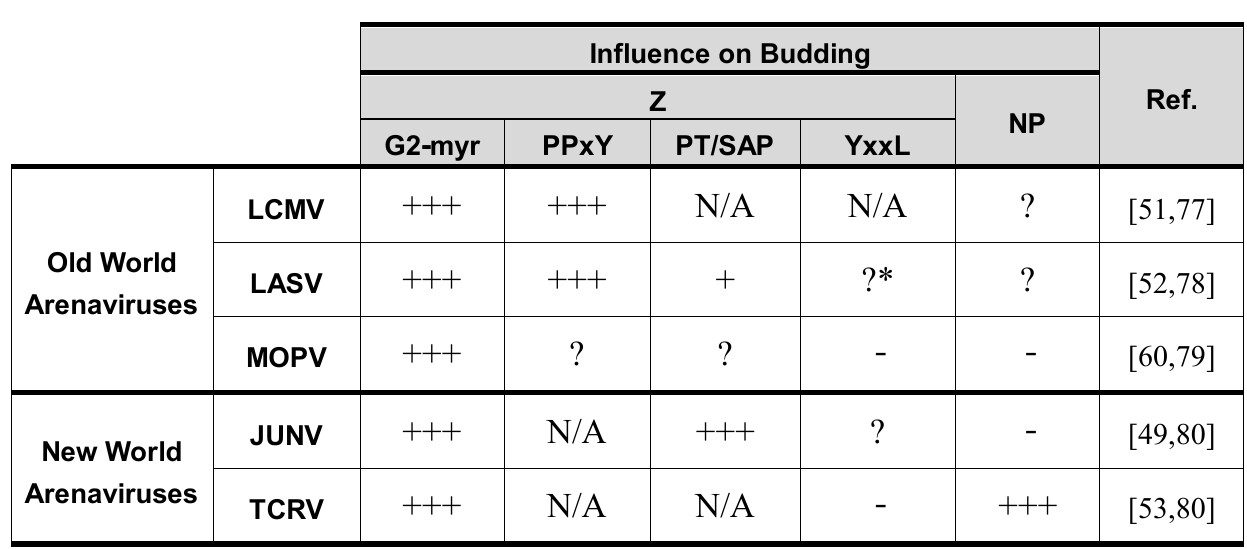
Table 3. Contributions of various matrix protein (Z) motifs and nucleoprotein (NP) to arenavirus